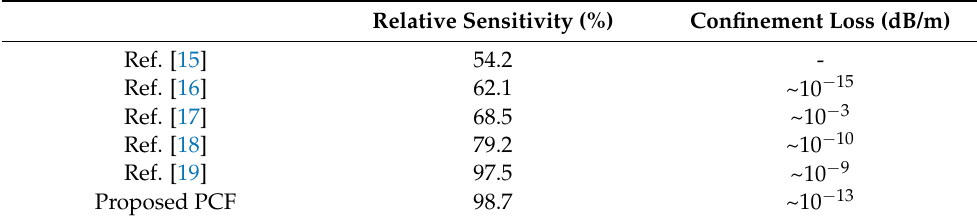
Table 3. Comparison of performance among prior PCFs and proposed PCF at λ = 1.1 µm.